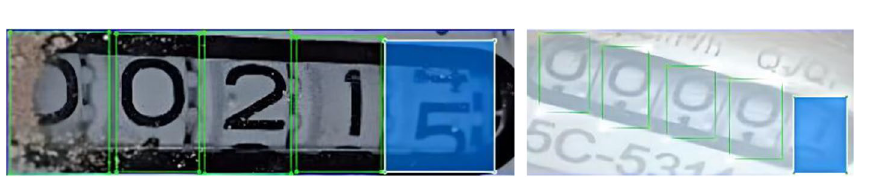
Figure 7. Annotations of some water meter images.